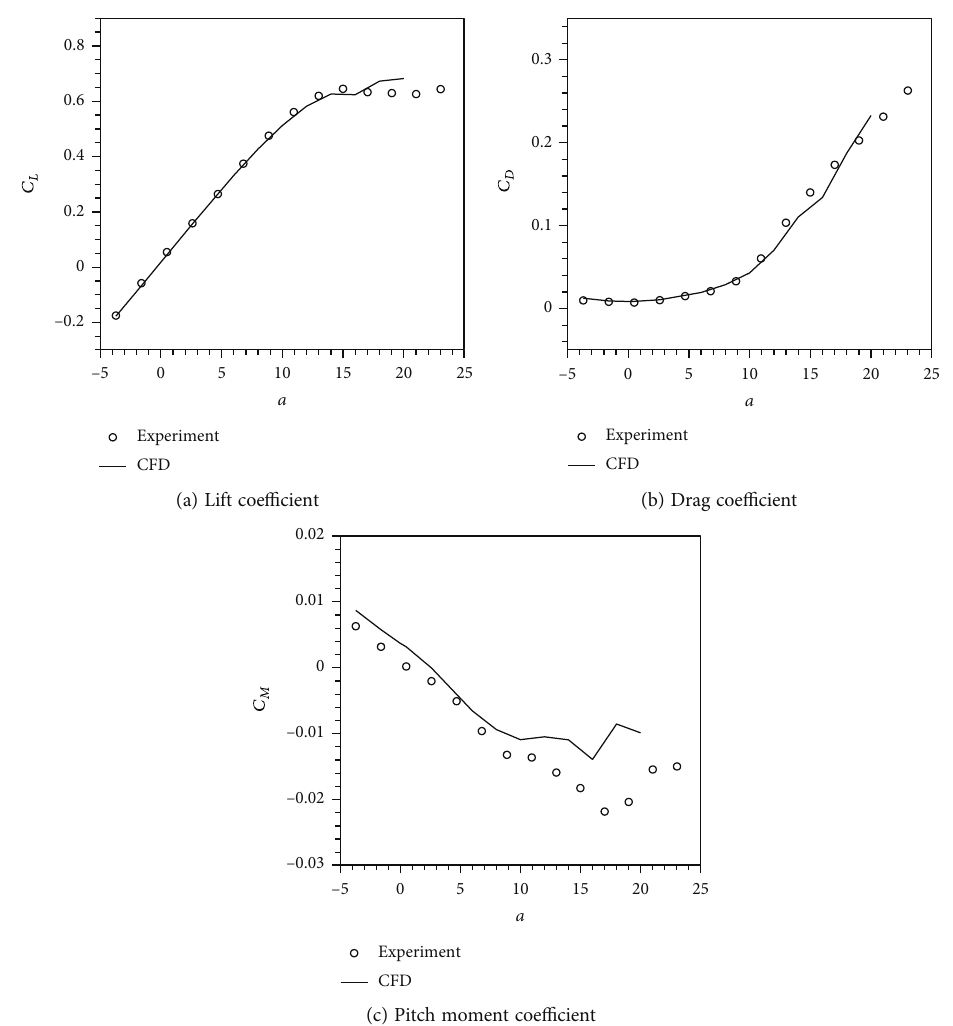
Figure 7: Typical aerodynamic characteristic curves of SWB at take-o ff